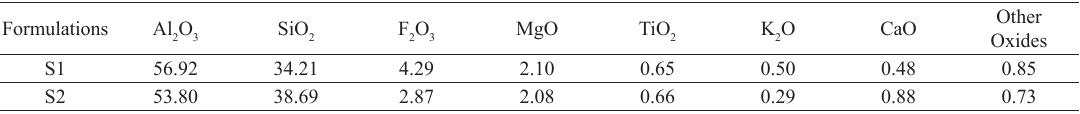
Table 1. Chemical composition (in %) of formulations S1 and S2.